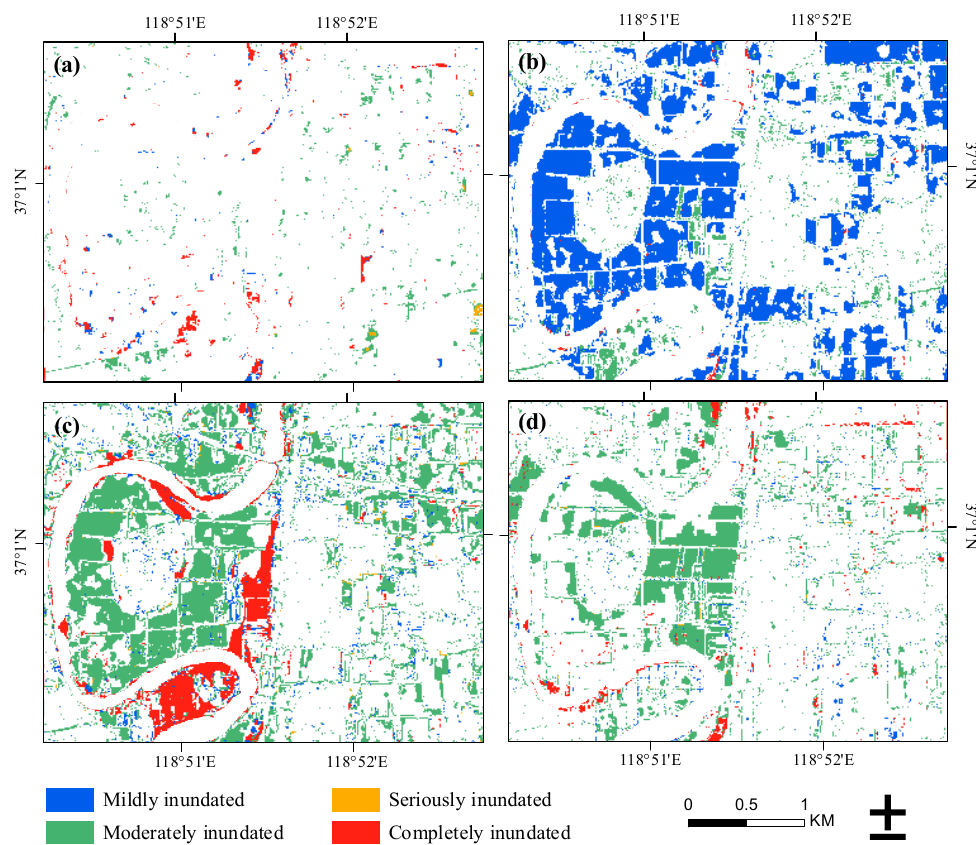
Figure 6. The flood extent maps on 21 July 2018 ( a ), 27 July 2018 ( b ), 20 August 2018 ( c ), and 26 August 2018 ( d ).